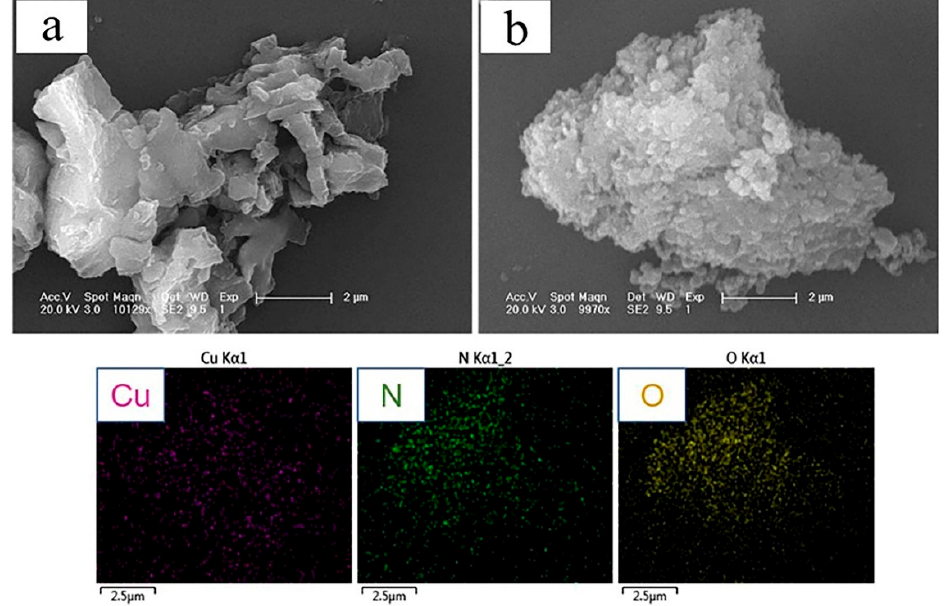
Figure 3. ( a ) SEM images of APP, ( b ) SEM images of APP-Cu@PDA, and mapping images of APP-